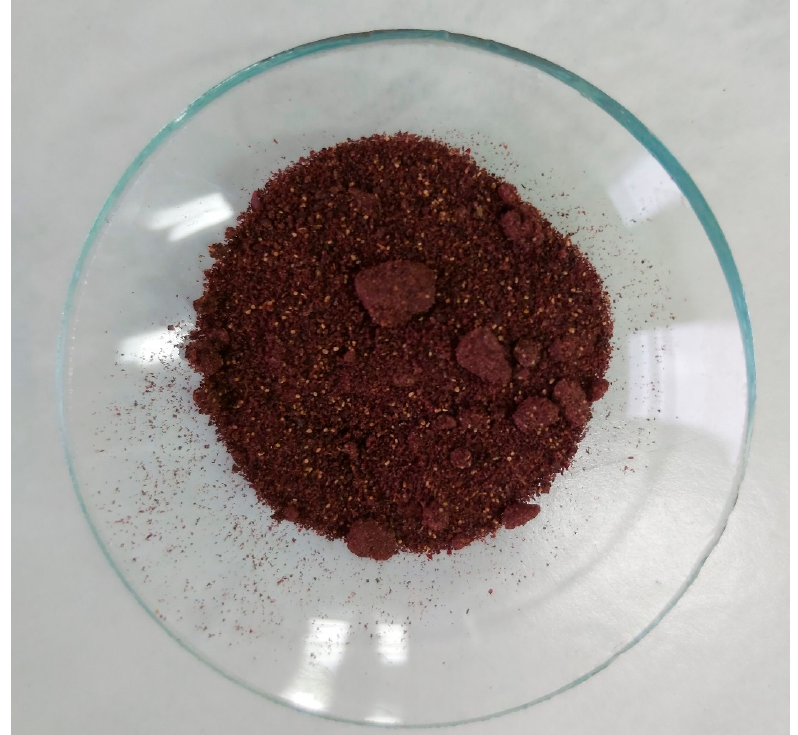
Figure 5. Picture of blue honeysuckle powder.